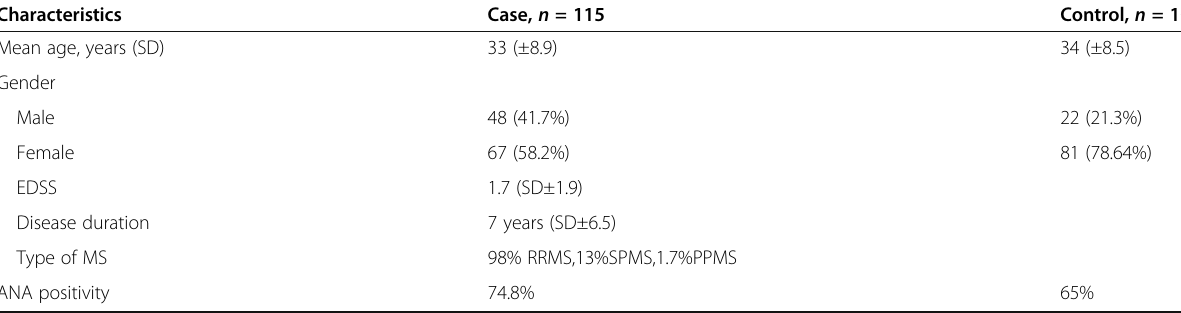
Table 1 Baseline characteristics of the MS and control groups